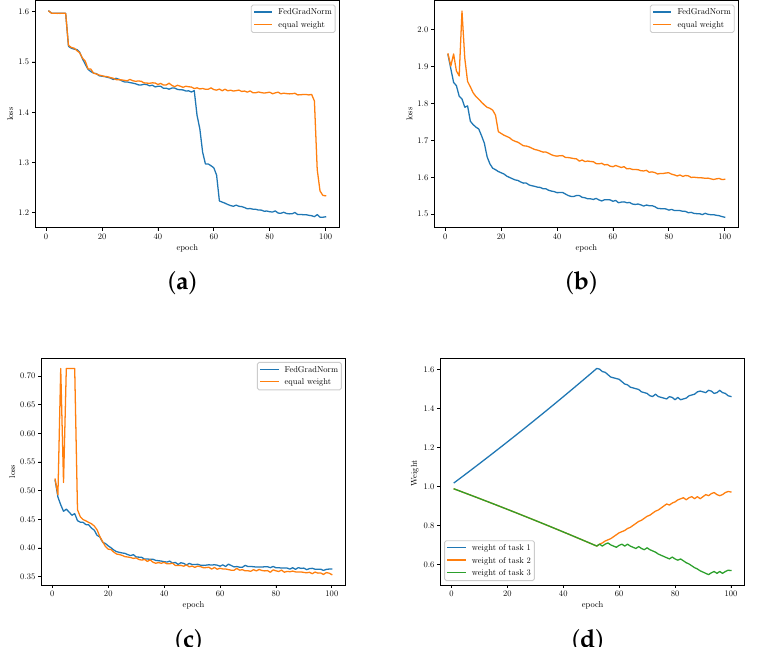
Figure 4. Comparison between task accuracy achieved via FedGradNorm and FedRep in RadCom- Dynamic dataset ( a ) task 1 (modulation classification), ( b ) task 2 (signal classification), ( c ) task 3 (anomaly behavior), ( d ) task